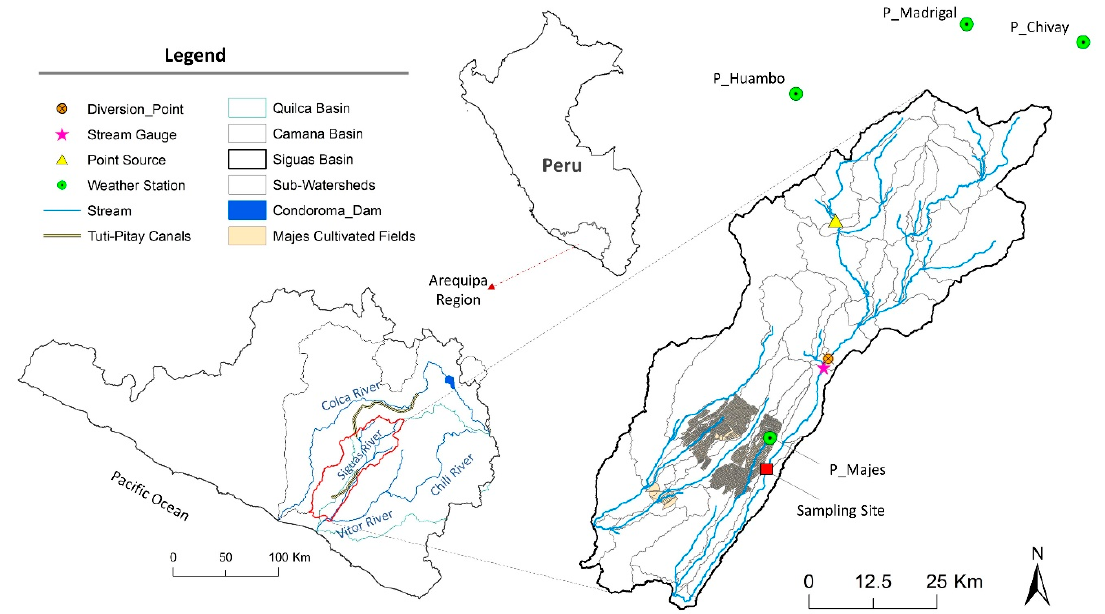
Figure 1. Locations of the study area’s boundary, climate stations, streamflow gauge, diversion points, and irrigation cultivated fields.